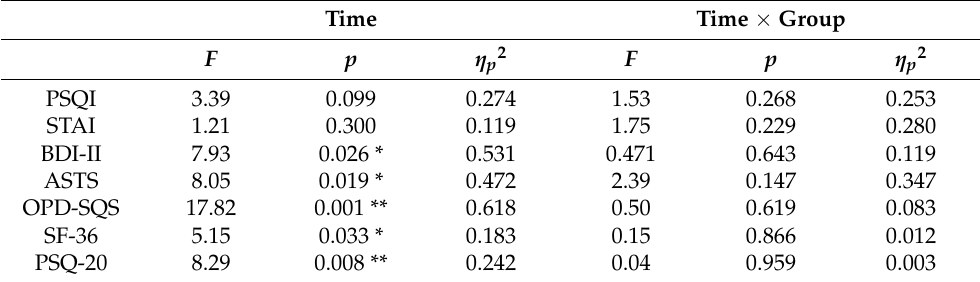
Table 2. RM-ANOVA results for psychological variables.